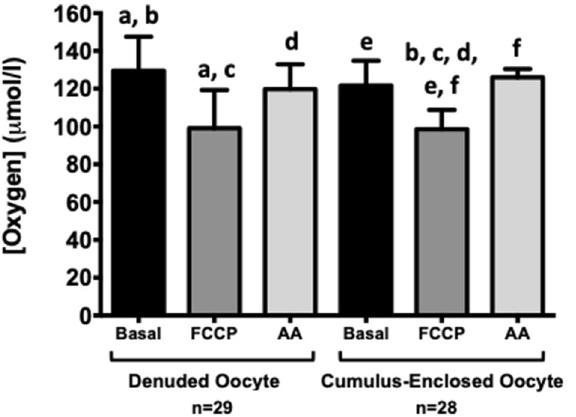
Figure 2. The effect of cumulus complex presence on oocyte oxygen concentration. Change in denuded oocyte icO 2 (n = 29): Basal (129.50 ± 18.07 µmol/l), FCCP treated (99.13 ± 20.14 µmol/l, p = 0.0002) and antimycin treated (119.7 ± 13.20 µmol/l, p > 0.05). Change in cumulus-enclosed oocyte icO 2 (n = 28): Basal (121.60 ± 13.15 µmol/l), FCCP treated (98.60 ± 10.20 µmol/l, p < 0.0001) and antimycin treated (126.00 ± 4.40 µmol/l, p < 0.005). Values plotted as mean ± SD for the number of analyses shown. Values with the same letter indicate significant differences by ANOVA with post-hoc Tukey test.